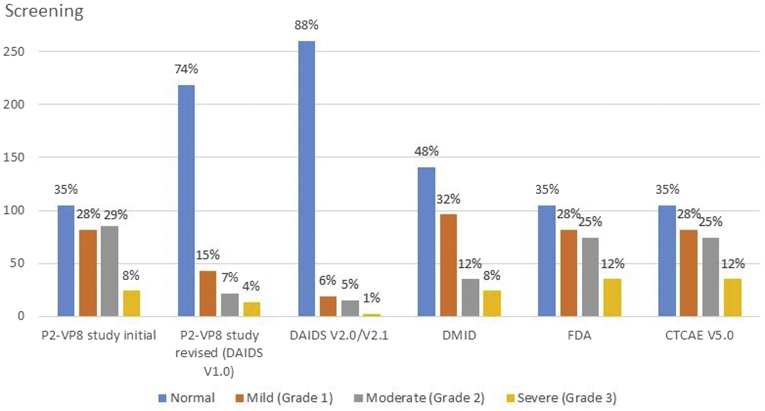
Grading of ANCs in healthy HIV-uninfected South African infants at screening (n = 296) using different toxicity grading scales. CTCAE, Common Terminology Criteria for Adverse Events Version 5.0 Nov 2017; DAIDS, DAIDS Table for Grading the Severity of Adult and Pediatric Adverse Events; V1.0 Dec 2004, clarification Aug 2009; V2.0 – November 2014; V2.1 – July 2017; DMID, Division of Microbiology and Infectious Diseases Pediatric Toxicity Tables Nov 2007; FDA, Guidance for Industry, Toxicity Grading Scale for Healthy Adult and Adolescent Volunteers Enrolled in Preventive Vaccine Clinical Trials 2007.